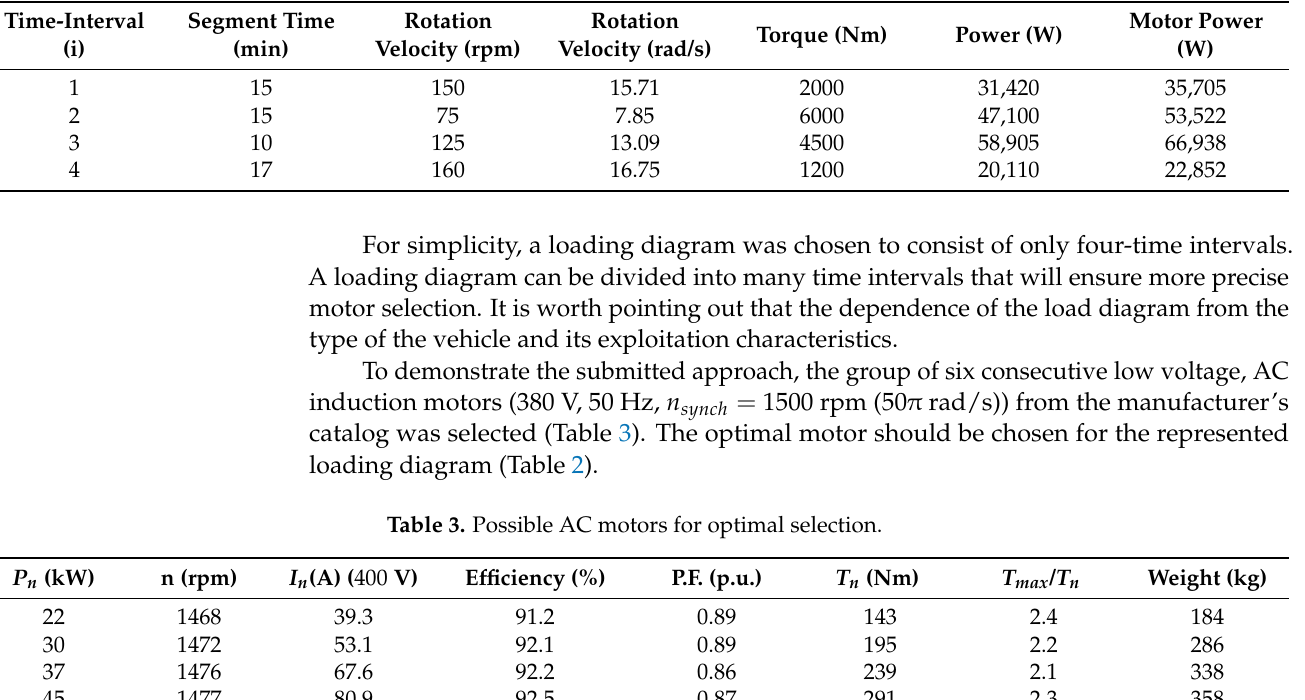
Table 2. Loading diagram of a vehicle.